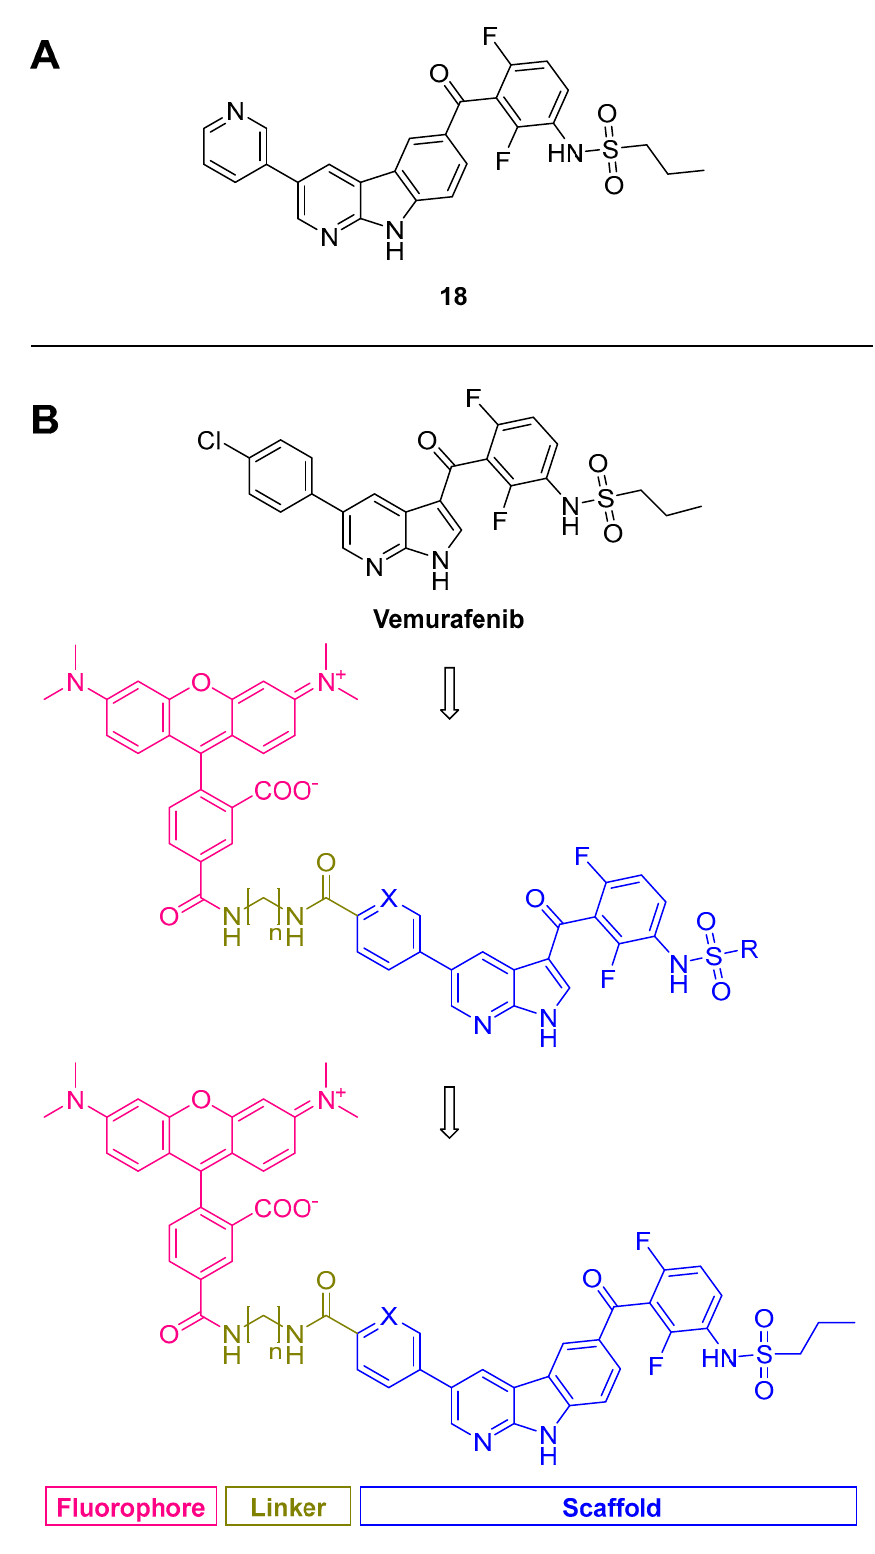
Figure 12. ( A ): Carboline compound 18 that was selected for screening. ( B ): Overview of the fluorophore attachment strategy. Scaffold with X = CH or N and R = propyl or benzyl (blue), attached by a linker with n = 1–6 (gold) to the fluorophore 5-TAMRA (5-carboxytetramethylrhodamine; pink). Adapted from Kircher et al. [128].